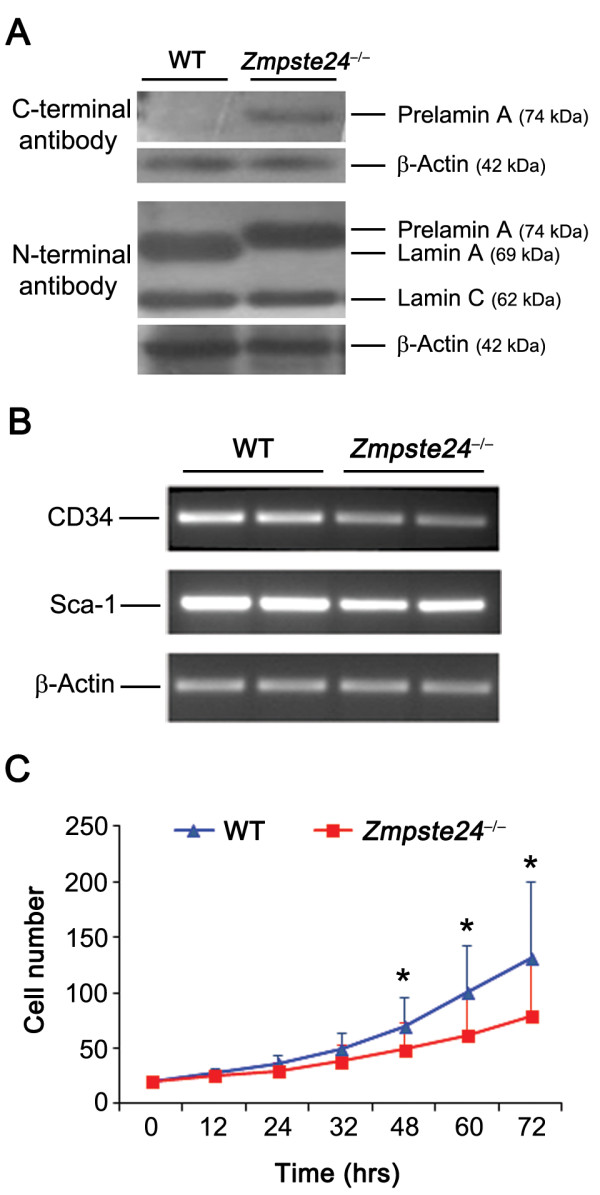
Prelamin A processing, stem cell marker expression, and proliferation potential are affected in Zmpste24-deficient muscle-derived stem/progenitor cells (MDSPCs). (A) Immunoblot analysis to measure the expression of the C-terminal prelamin A and N-terminal lamin A/C in WT and Zmpste24-/- MDSPCs relative to β-Actin. (B) RT-PCR to measure expression of stem-cell markers, CD34 and Sca-1, in MDSPC populations (n = three to four cell populations per group). (C) Proliferation of MDSPC populations was measured with a live cell-imaging system for 72 hours. Plotted are averages of normalized cell numbers at each time point calculated from the analysis of three cell populations per group, ± SD. *P < 0.001, Mann-Whitney Rank Sum test.